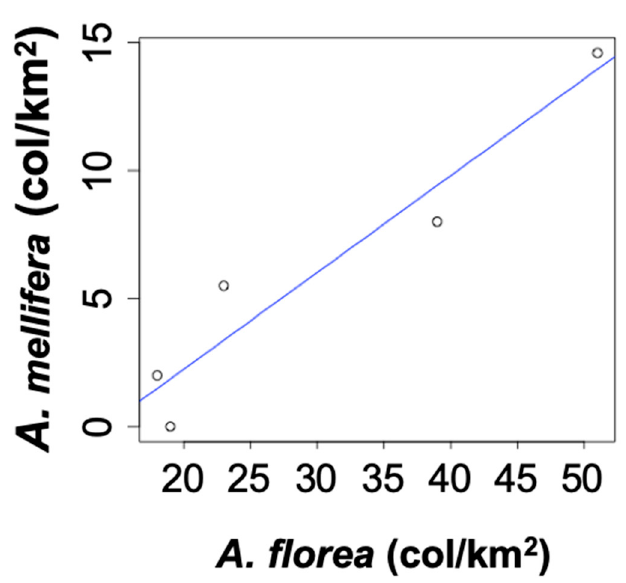
Figure 3. Correlation of colony densities between A. florea and A. mellifera along the river Nile valley sampling transect.